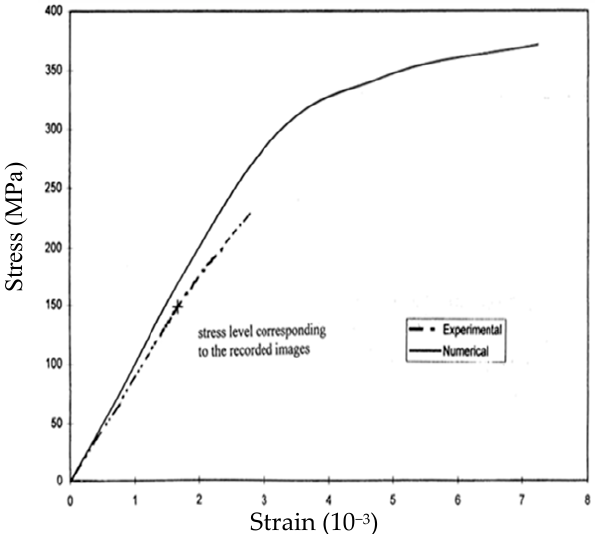
Figure 10. Stress–strain curves of the Al–SiC composite specimen subject to tensile loading.